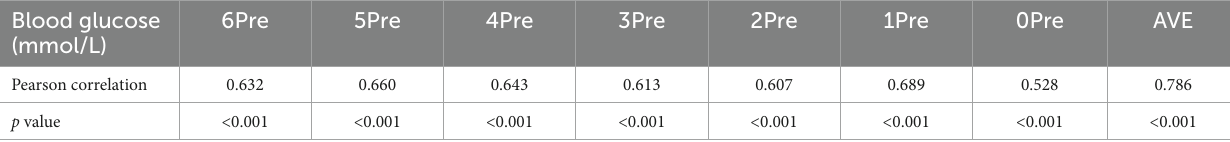
TABLE 2 Correlation analysis between the cerebrospinal fluid glucose level and blood glucose level in patients in the group with abnormal glucose metabolism. Blood glucose (mmol/L) Pearson